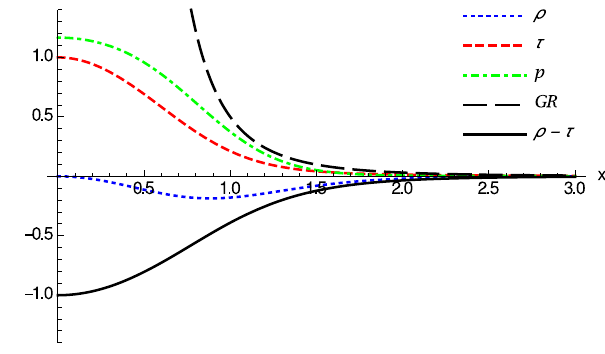
Fig. 2 Graphical representation of the components ˜ ρ (blue dotted), ˜ τ (red thin dashed) and ˜ p (green dashed-dotted) of the stress-energy tensor (24) as a function of x for regular horizonless solutions ( δ 1 = δ c ) with N q = N (cid:18) c , which represents the transition case where the horizon disappears. At large distances all these components reduce to those of the Reissner–Nordström case (black thick dashed, upper curve in this figure), N q /( N (cid:18) c x 4 ) [see Eq. (31)]. The solid black line (lower curve in this figure) represents ˜ ρ − ˜ τ < 0, which means that the NEC is violated near the wormhole throat